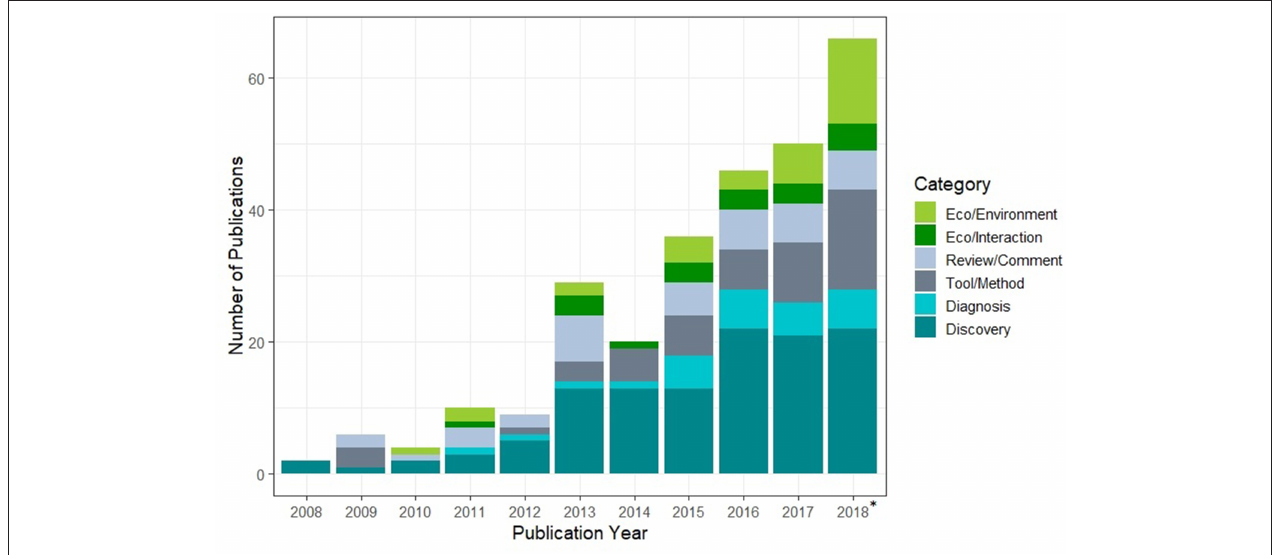
FIGURE 1 | A Web of Science search for combinations of the words metabarcod* or metagenom* or eDNA and emerging pathogen, parasite, or emerging disease revealed 278 relevant publications, demonstrating the accelerating interest in using HTS approaches to understand the ecology of emerging diseases across a range of applications. Articles for 2018 do not include December publications. Categories were defined as: Eco/Environment—HTS used to detect changes across pathogen communities in different environments, Eco/Interaction—interactions of microbiota or other organisms with pathogen communities, Review/Comment—reviews or commentaries, Tool/Method—new protocols, tools, or comparisons of methods, Diagnosis—HTS used to diagnose disease or identify aetiological agents, Discovery—HTS used to discover or describe new